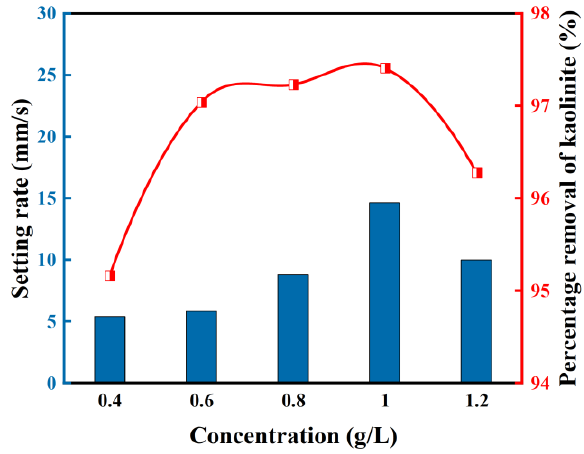
Figure 4. Percentage removal and settling rate of kaolinite at different PEO concentrations.